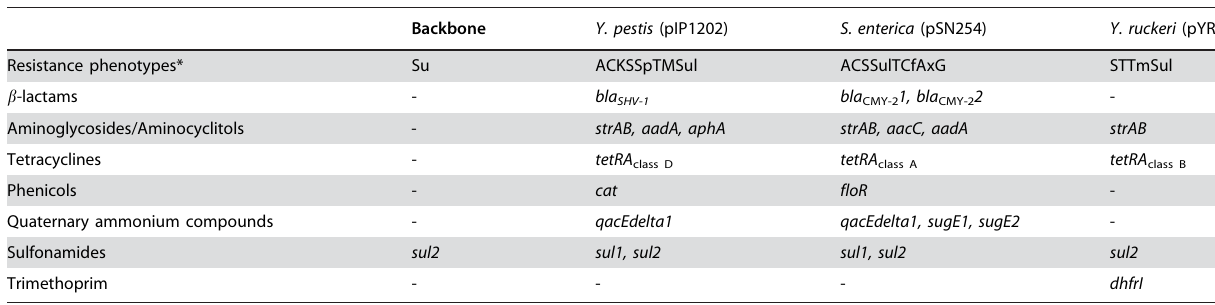
Table 1. Antimicrobial resistance determinants. .. ... .... ... ... .... ... ... .... ... ... .... ... ... .... ... ... .... ... ... .... ... ... .... ... ... .... ... ... .... ... ... .... ... ... .... ... ... .... ... ... .... ... ...